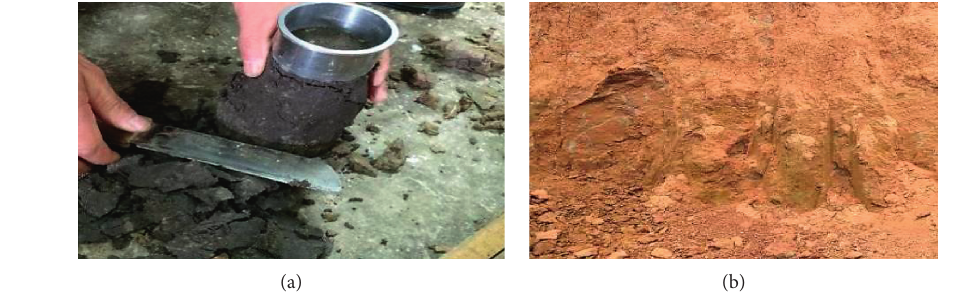
Figure 1: Expansive soil (a) in Heilongjiang (b) in Ankang. Table 1: Physical indexes and mineral compositions of the sample. Physical indexes of sample